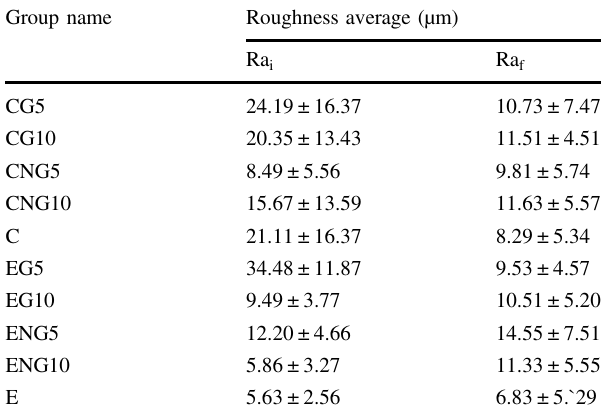
Table 2 Pre and post-test roughness average of commercial and experimental novel composite